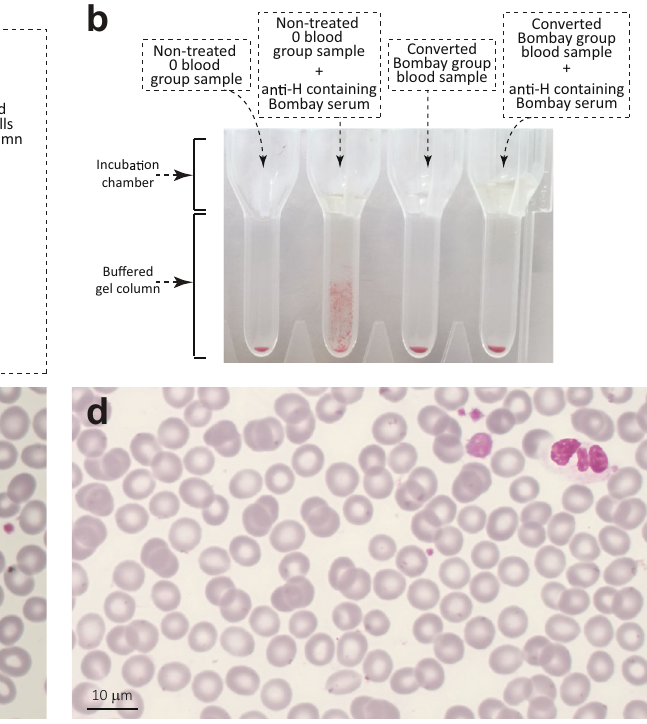
in the third column in converted Bombay blood group sample; negative/non- agglutinated result in converted Bombay blood group sample in contact with H antibodiesnaturallycontainingBombayserum. c Non-treatedObloodgroupsmear picture. RCBsare shownwith normal biconcave morphology. Thisexperiment was performed on two different samples. d Converted O blood group to Bombay sample ’ s smear picture. RCBs are shown to maintain normal biconcave morphol- ogy. This experiment was performed on two different